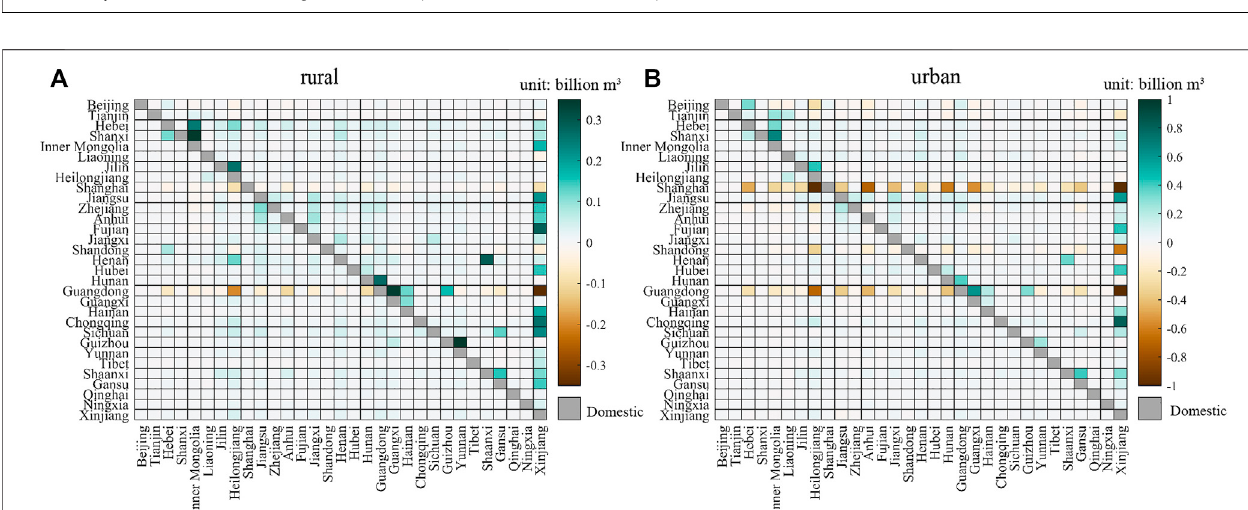
FIGURE 5 | The effects of rural consumption pattern on cross-regional provincial water footprints (A) , and the effects of urban consumption pattern on cross- regional provincial water footprint (B) .